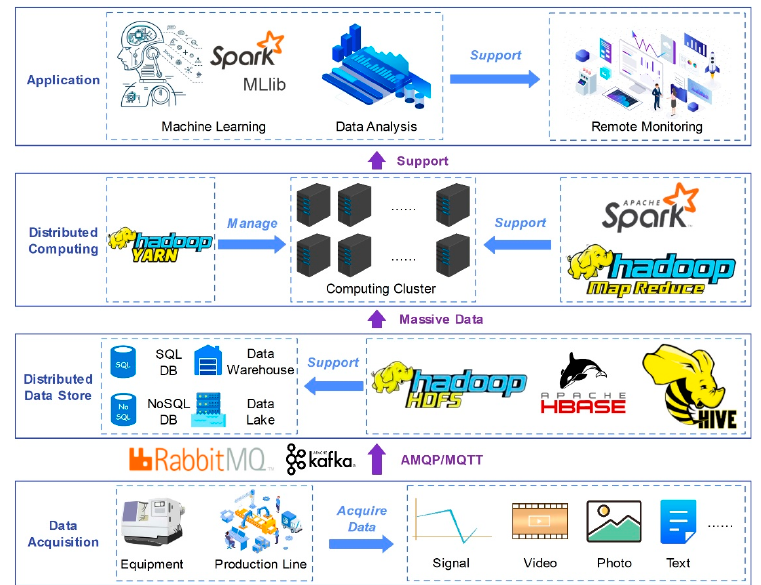
Figure 9. Big data application